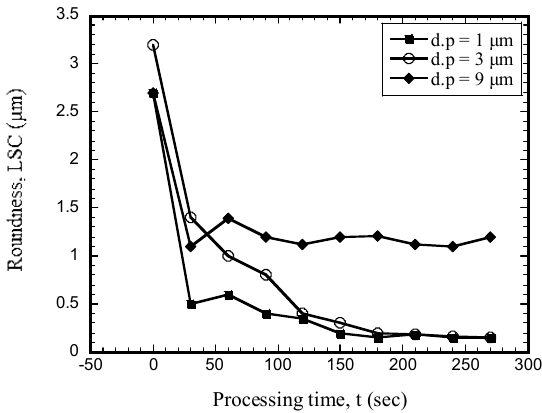
Figure 5. Variations of roundness against processing time. (diamond paste weight: 200 mg, frequency of magnetic poles: 12 Hz).